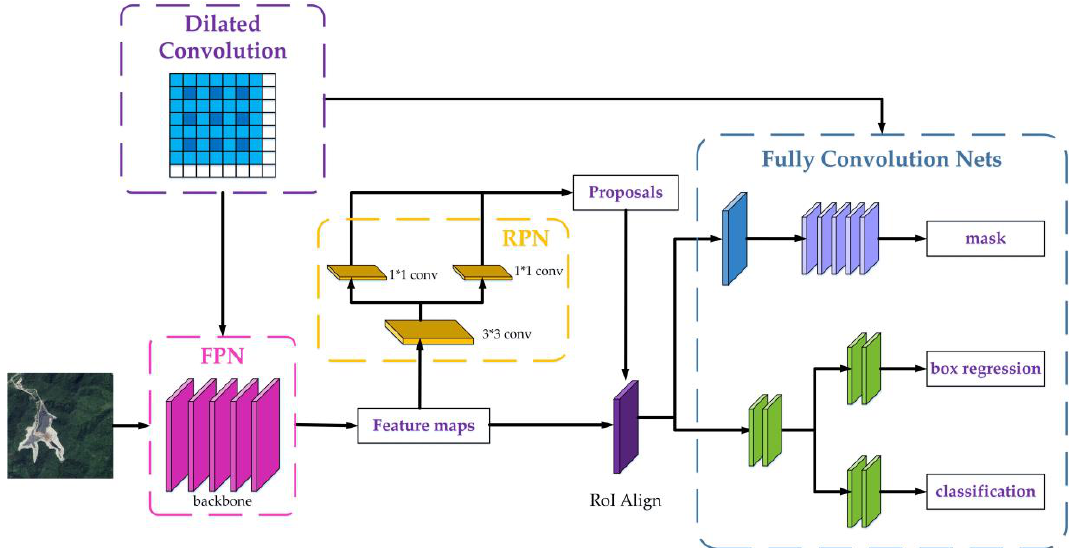
Figure 2. Mask R-CNN network generalization diagram.